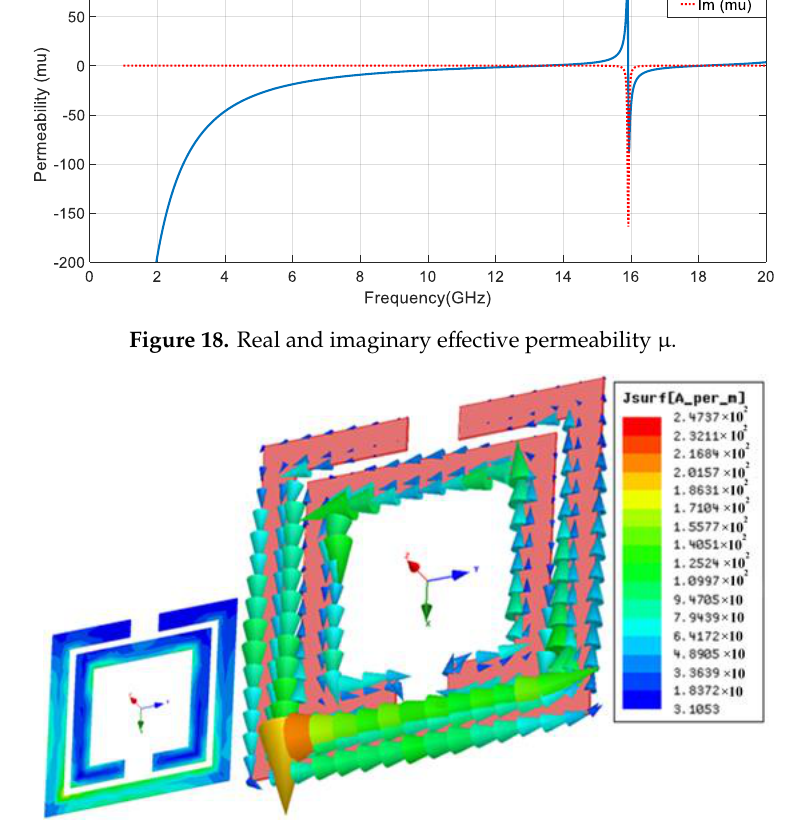
Figure 19. Surface current density and its vectors for square SRR.